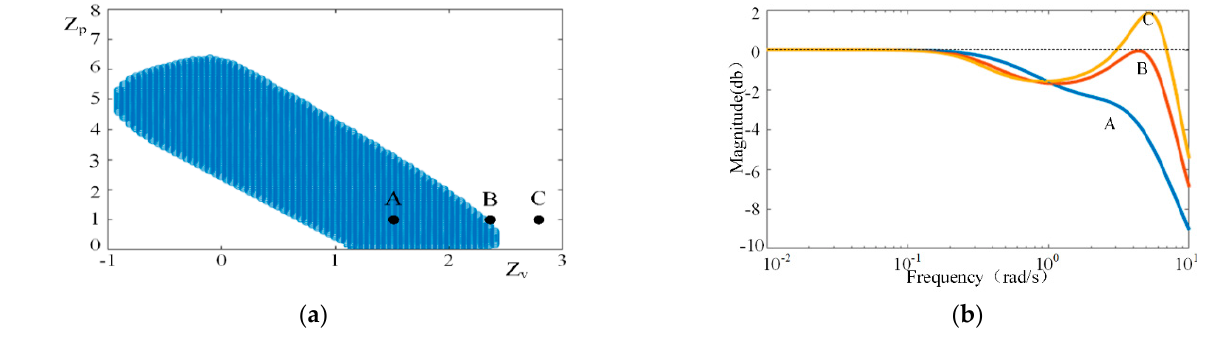
Figure 2. ( a ) Grain truck and crop harvester follow system stability; ( b ) Bode diagrams of stability at different